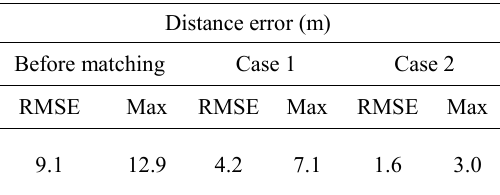
Table 3. Location errors between NCPs-GPS points and the surface points of